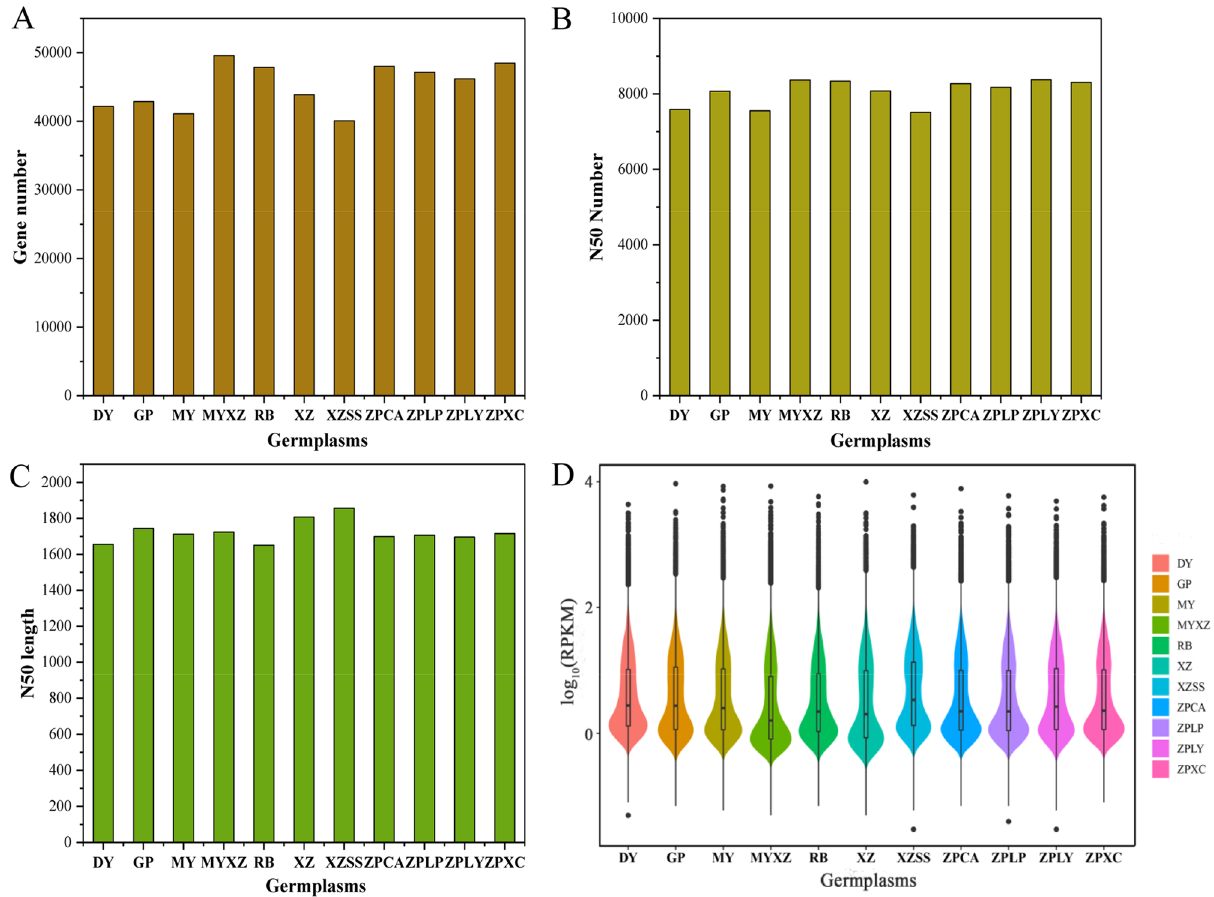
Figure 2. Assembling results and gene expression distribution in 10 germplasms of Chaenomeles and Docynia delavayi ( D. delavayi ). In this graph, A represents the gene numbers in the 11 materials; B represents the N50 numbers in the 11 materials; C represents the N50 length in the 11 materials; D is a violin graph of the gene expression distribution in the 11 materials. On the X-axis, DY represents D. delavayi (DY), GP represents C.sinensis (GP), MY represents C. cathayensis (MY),XZ represents C. thibetica (XZ), MYXZ represents C. thibetica (MYXZ), XZSS represents C. thibetica (XZSS), RB represents C. japonica (RB), ZPCA represents C. speciosa (ZPCA), ZPLP represents C. speciosa (ZPLP), ZPLY represents C. speciosa (ZPLY), and ZPXC represents C.speciosa (ZPXC). In violin graph, different colours represent different germplasms. The area and width of the violin graph represent the expression abundance of the expressed genes in the corresponding germplasms. The expression levels in vertical coordinates are standardized by the log 10 (RPKM) algorithm. The histograms were visulized by Origin pro 2016, violin graph was visulized by R